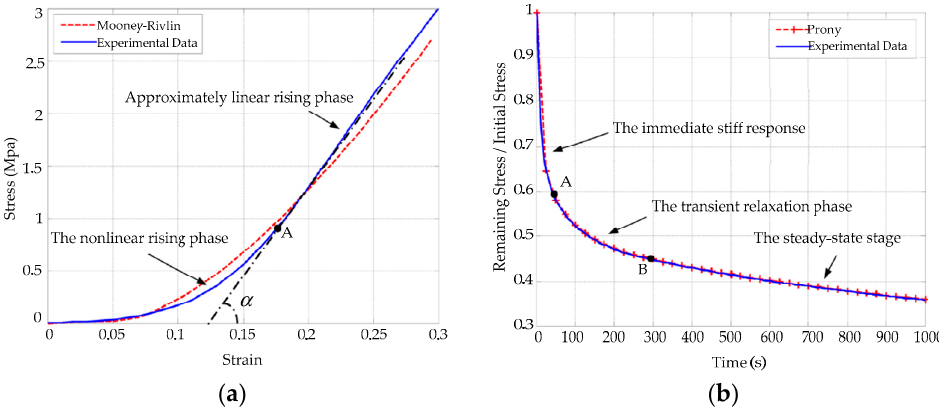
Figure 1. Simulation and experimental results of the corneal Mooney–Rivlin hyperelastic model and the Prony series viscoelastic model: ( a ) simulation and experimental comparison curves corresponding to Equation (1); ( b ) corneal stress relaxation curves corresponding to Equation (2). Simulation results are shown with dotted lines and experimental results are shown with solid lines.